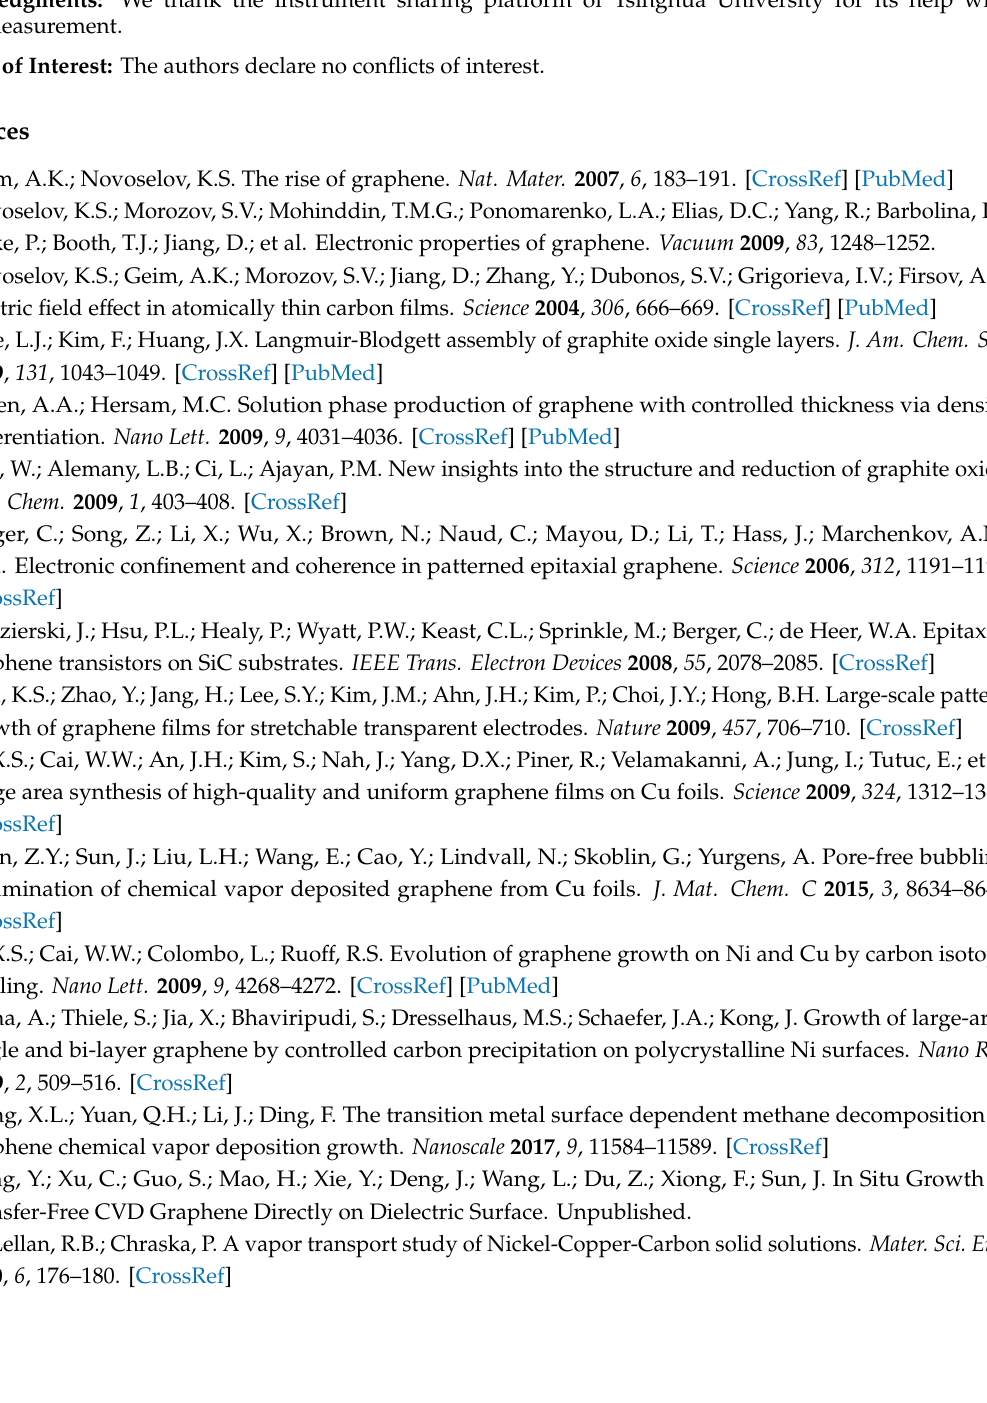
Figure S3: Optical images of the Ni-catalyzed graphene grown at di ff erent temperatures. When the growth temperature is lower than or equal to 450 ◦ C, the surface of the obtained sample has no graphene growth, which indicates that the lowest growth temperature of Ni-catalyzed graphene is about 450 ◦ C. Figure S4: Digital images of the growth chamber before graphene growth (a), after several rounds of graphene growth (b) and after H 2 plasma etching (c). The selection of alloys for low temperature